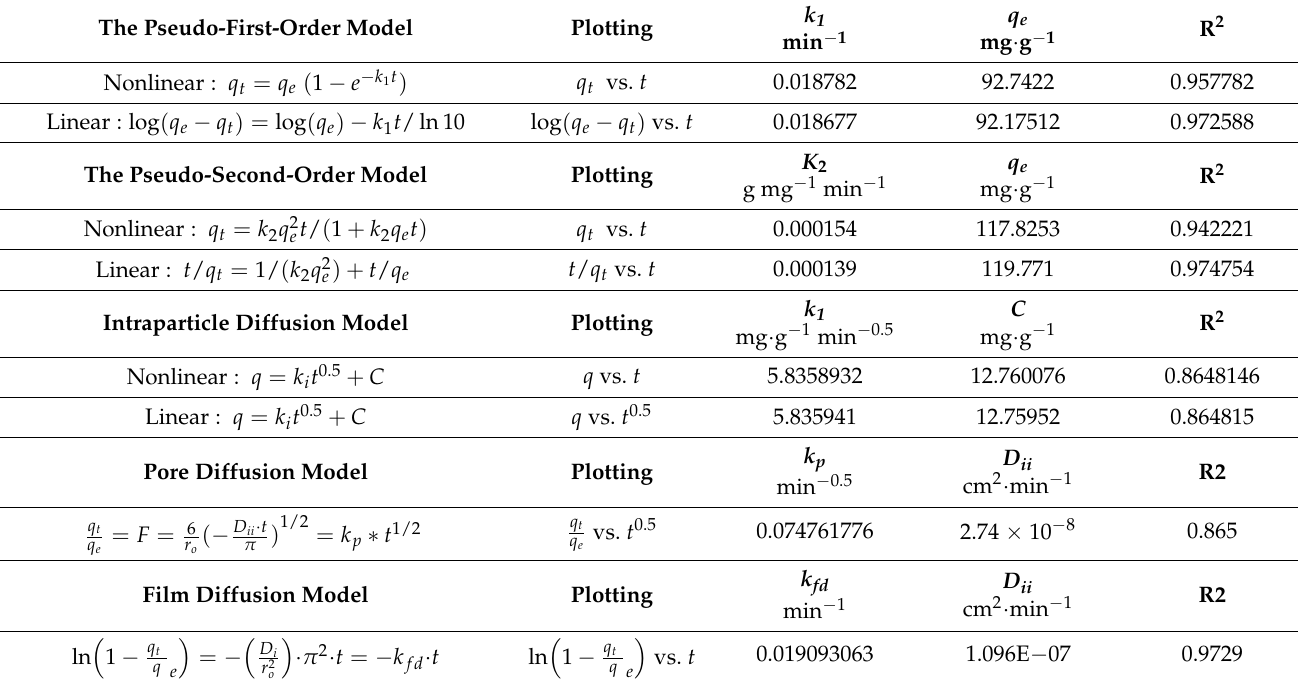
Table 6. Obtained data from fitting experimental results with the three tested